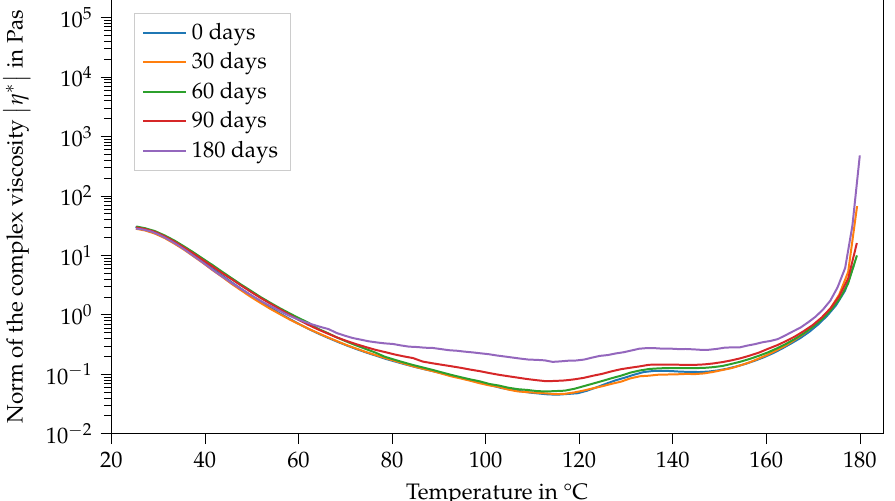
Figure 10. Norm of the complex viscosity of Argopox-2.5 between 25°C and 180°C after storage periods of 0d, 30d, 60d, 90d and 180d at T = −